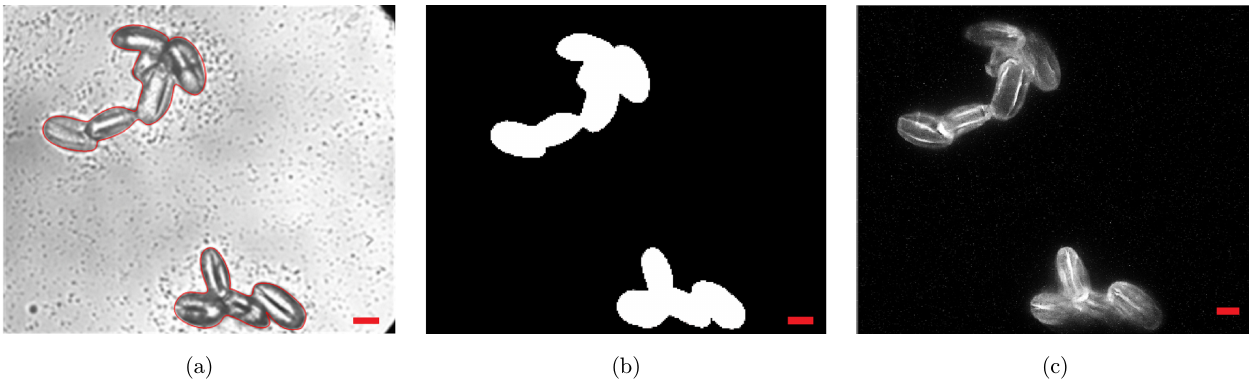
Fig. 5. The process of imaging pollen grains of interest. (a) The white light image of pollen grains in the wide ¯eld mode in which the boundary of samples of interest is marked by the red curve; (b) the required excitation light pattern matching the samples of interest and (c) the two-photon °uorescence image of pollen grains of interest. Scale bar is 10 (cid:1) m.